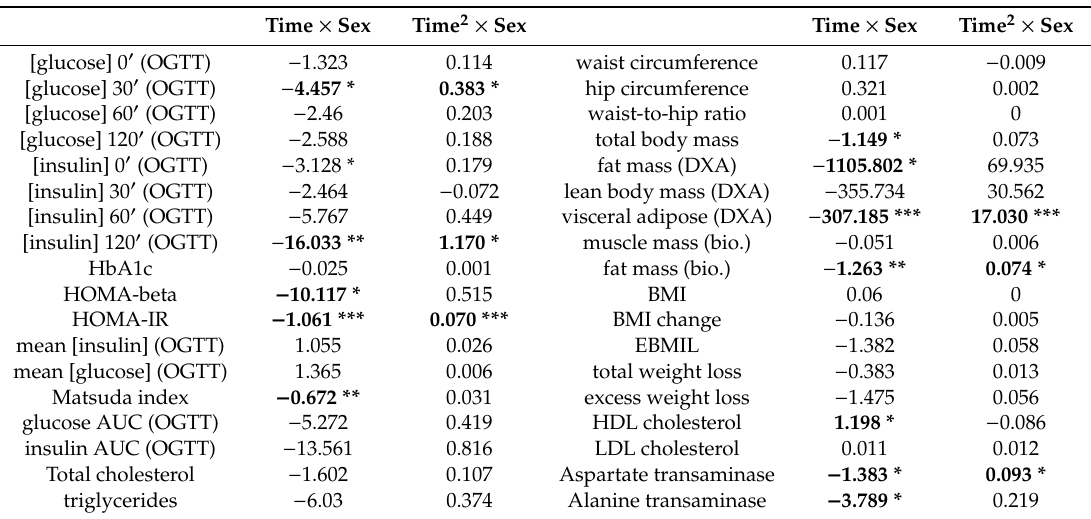
Table 4. Time × sex coe ffi cients from GLMMs and significances adjusting for age, sex, diet, and physical